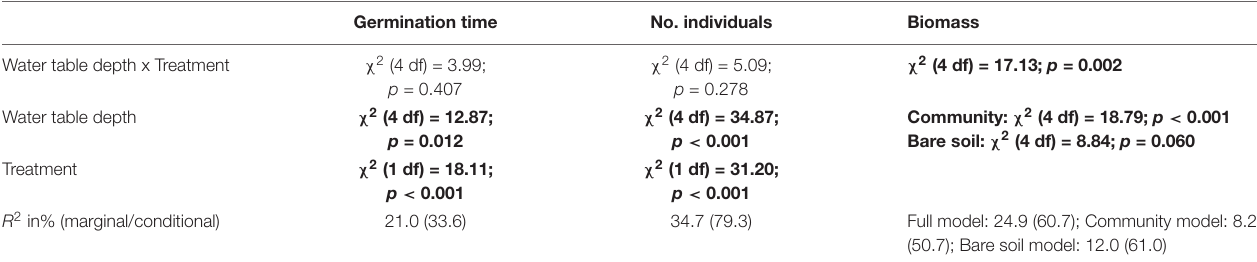
TABLE 1 | Linear mixed effect models for germination time of Bunias orientalis in the first season (2016) and biomass over 3 years (2016–2018), and generalized linear mixed model for number of individuals over 3 years.